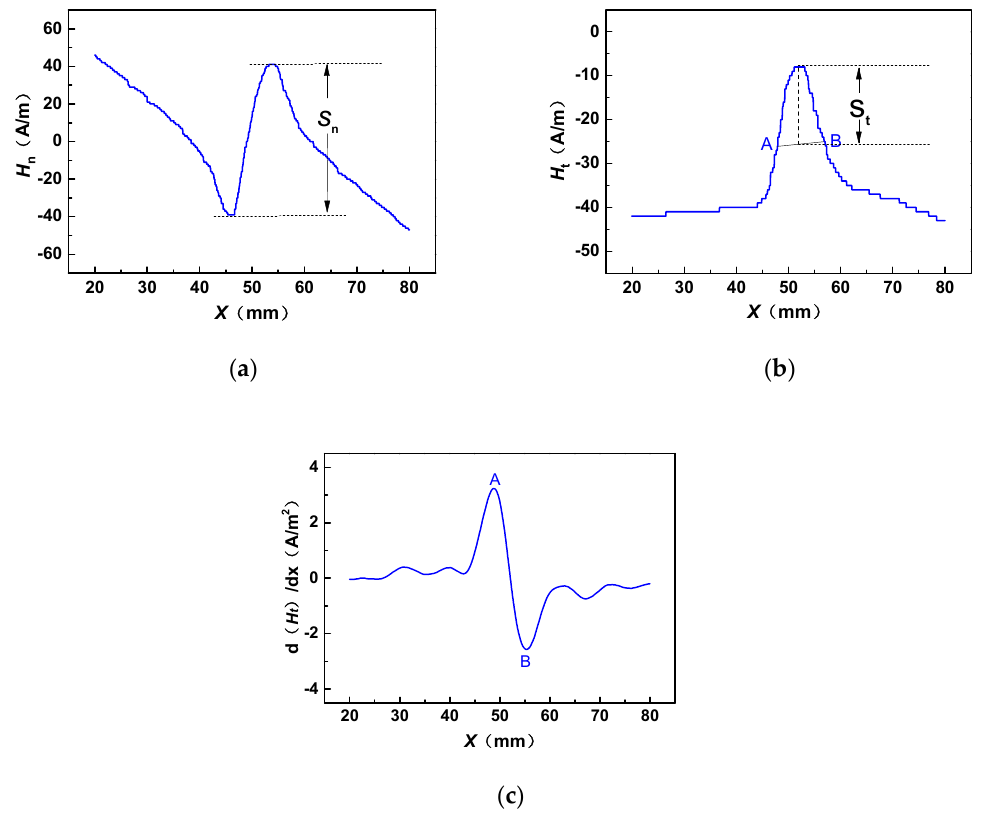
Figure 13. The calculation methods of magnetic characteristic parameters: ( a ) calculation method of S n ; ( b ) calculation method of S t ; ( c ) gradient of H t .